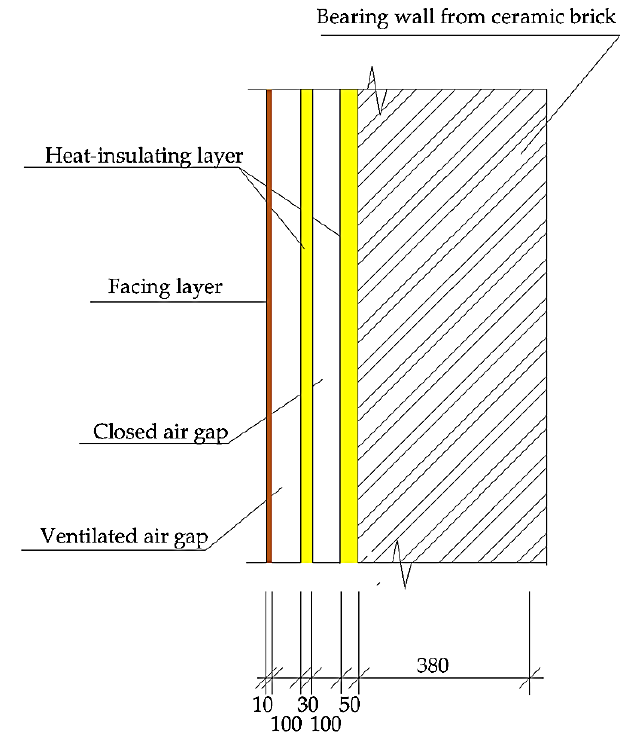
Figure 2. multilayer wall enclosing structure with homogeneous bearing, heat-insulating layers and ventilated air gaps (the thickness of the layers of the structure is given in millimeters).